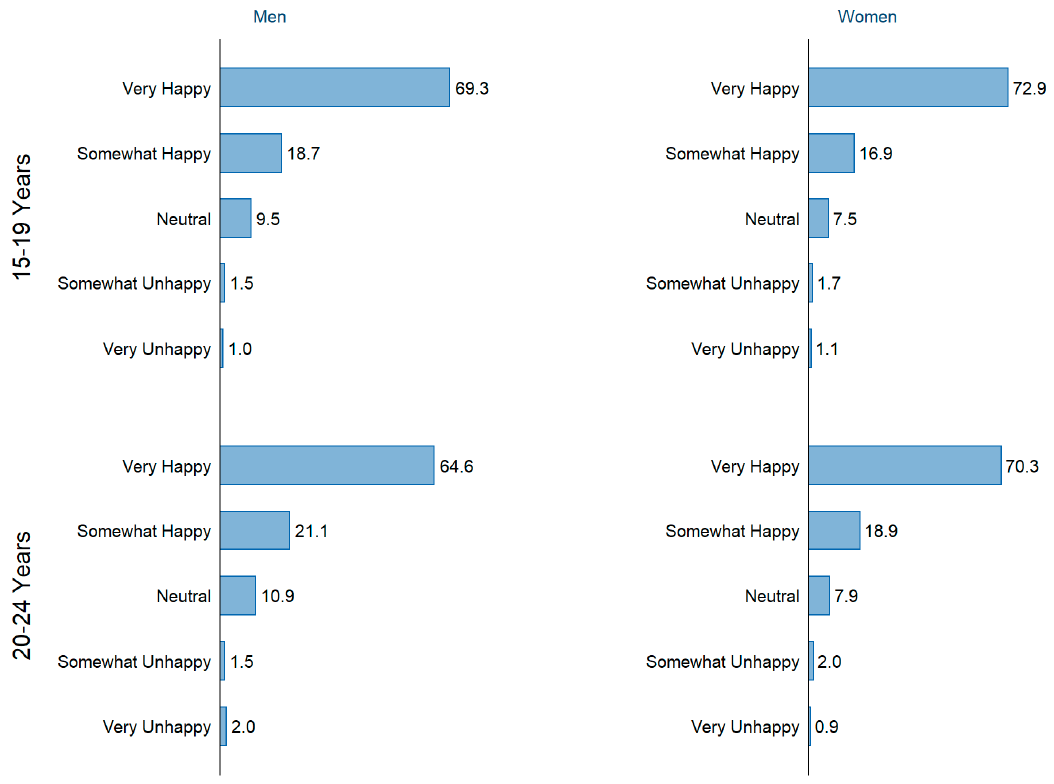
Figure 2. Proportion of men and women by self-reported happiness. Soc. Sci. 2019 , 8 , x FOR PEER REVIEW